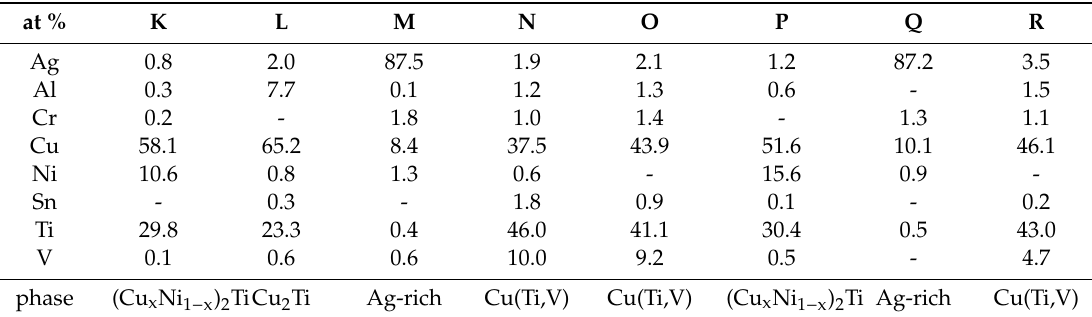
Figure 6. FESEM BEI observations of Ti 50 Ni 50 / BAg-8 / Ti-15-3 joints brazed at ( a ) 800 and ( b ) 850 °C for 300 s. Table 4. Chemical analyses in Figure 6 .